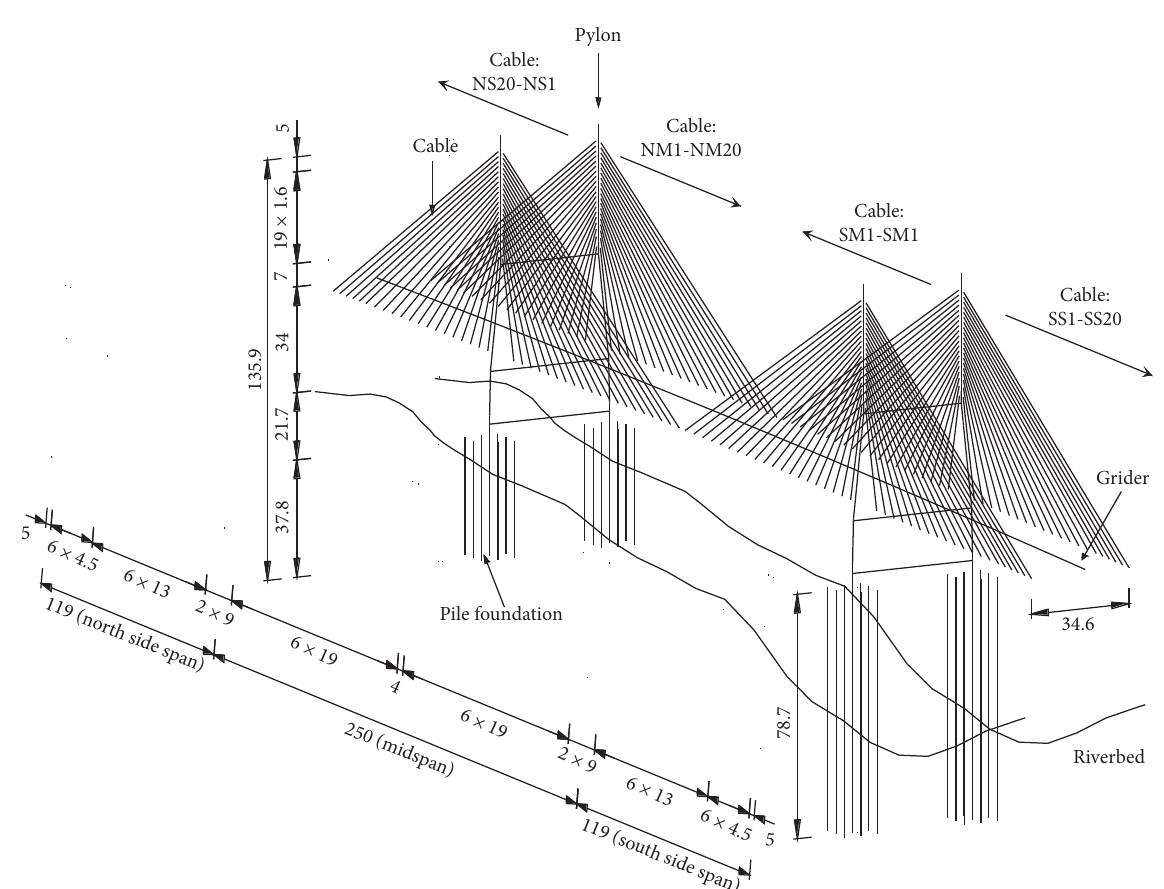
Figure 2: General layout of the bridge (m). Note: NS means north side span, NM means north midspan, SS means south side span, and SM means south midspan.